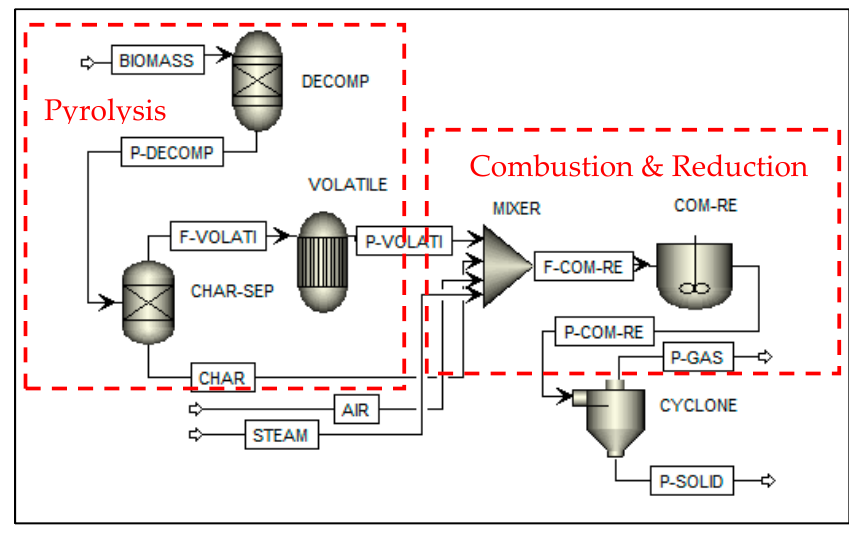
Figure 1. The schematic diagram of simulation model for the steam gasification process.